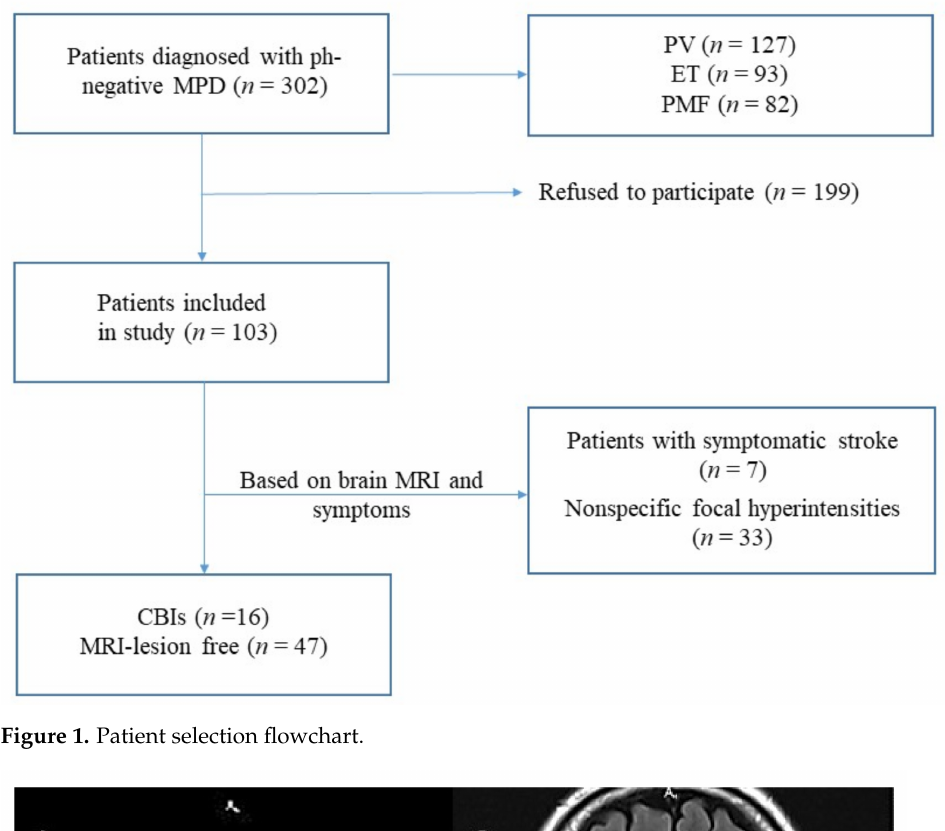
Figure 1. Patient selection flowchart.